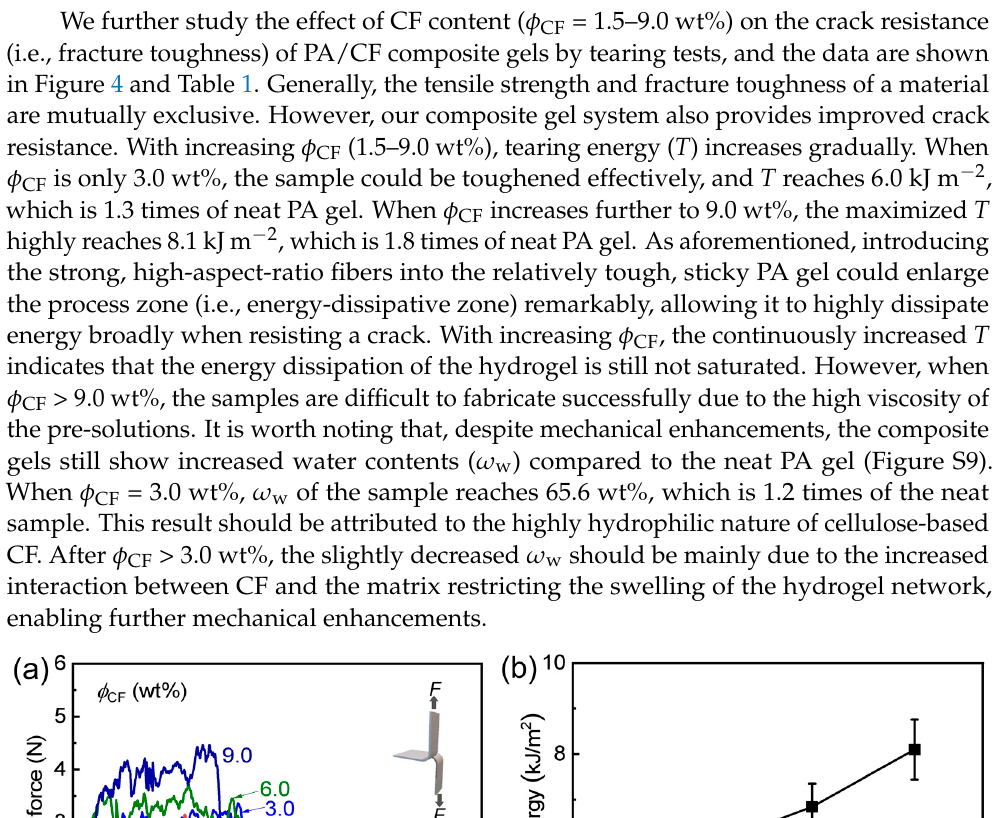
Figure 5. Lap-shear adhesion behavior of two pieces of PA/CF composite hydrogels with different ϕ CF . ( a ) Adhesive shear force ( F )-extension ( Δ ) curves of the samples. ( b ) Adhesive strength versus ϕ CF . Table 2. A summary of the adhesion properties of PA/CF composite hydrogels with different CF contents (shown in Figures 5–7). Sample Code